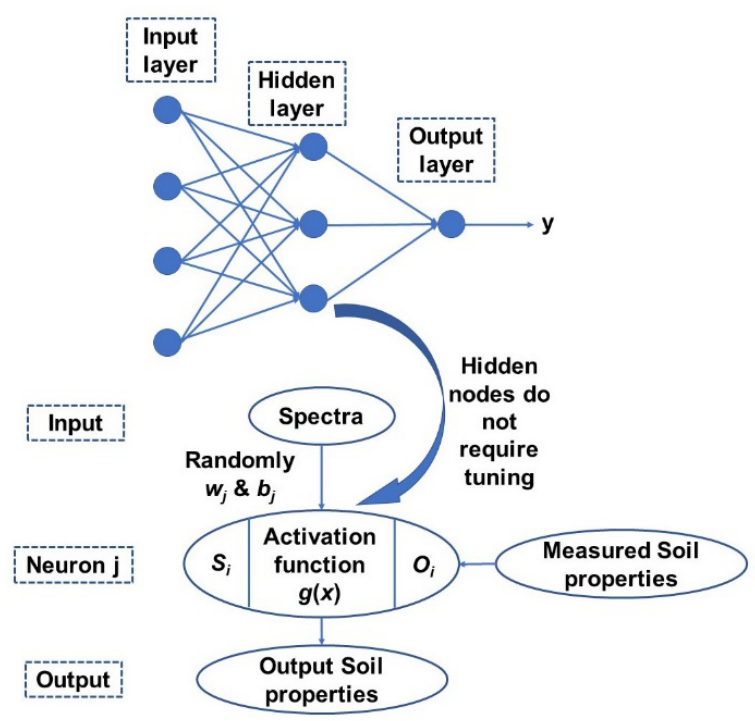
Figure 4. A general structure of the ELM model adopted in this study [46] .